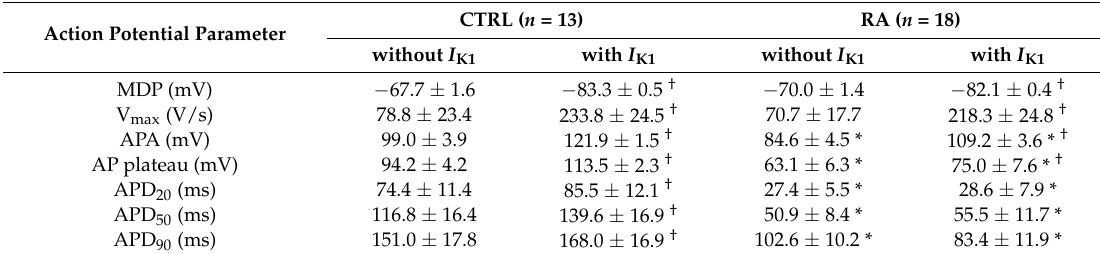
Data are mean ± SEM. CTRL: control cells; RA: retinoic acid-treated cells; n : number of cells; MDP: maximum diastolic potential; V max : maximum upstroke velocity; APA: action potential amplitude; AP plateau: AP plateau amplitude; APD 20 , APD 50 , and APD 90 : action potential duration at 20%, 50%, and 90% repolarisation, respectively. * p < 0.05 RA vs. CTRL. † p < 0.05 with vs. without I K1 injection.